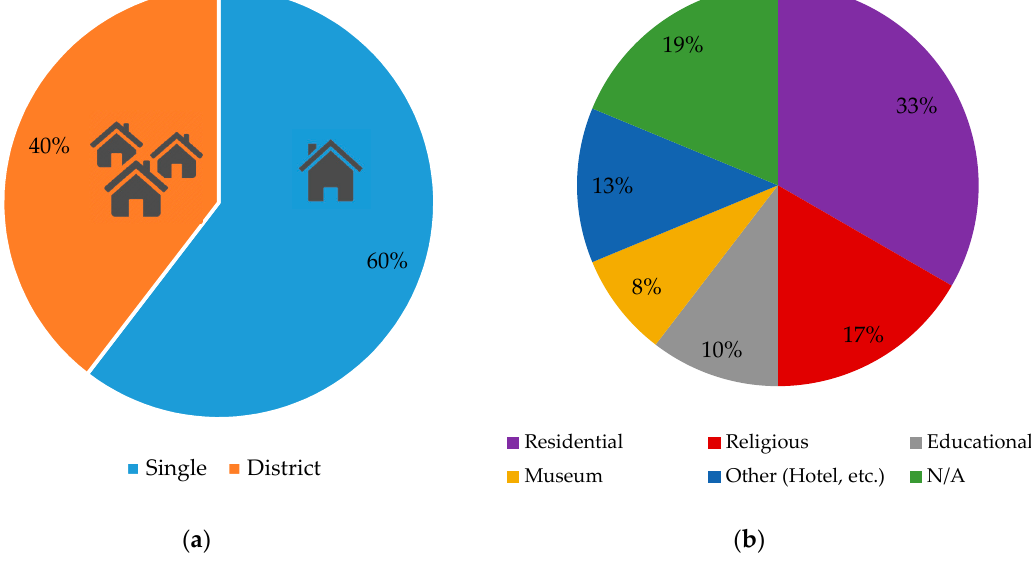
Figure 6. Findings from the systematic literature review: ( a ) categorisation of the scale of intervention at building (blue) or district level (orange); ( b ) categorisation of the building by its function.